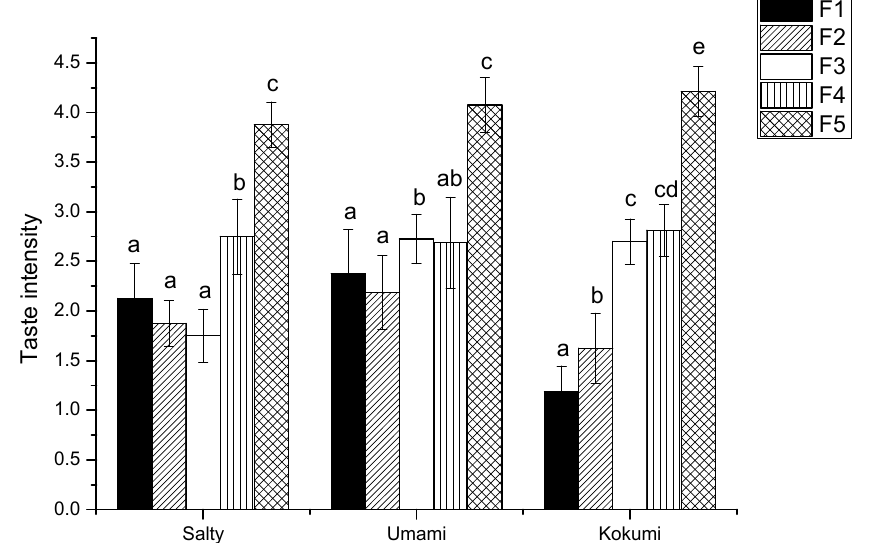
Figure 2. Salty, umami, and kokumi taste intensity of GPC fractions in model chicken broth. a, b, c, d, e The different letters in the same group represent that there are significant differences at the level of p < 0.05, and the same letters represent no significant difference.